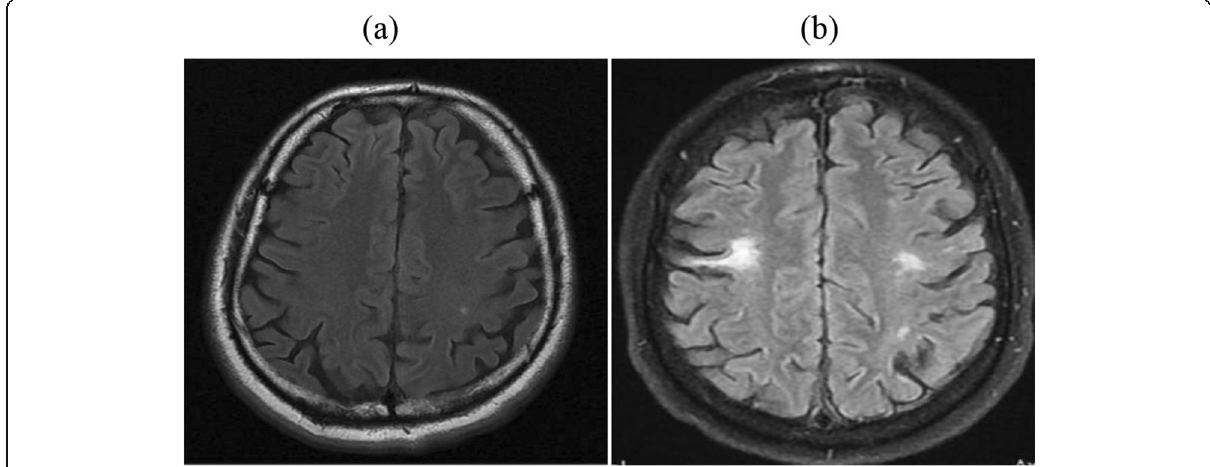
Fig. 1 a Axial FIAIR brain MRI exhibits non-specific hypertense white mater lesion in the left parietal region. b Axial FIAIR brain MRI exhibits hyperintensity lesions in both frontal subcortical white matter regions suggesting subacute infarcts. FIAIR, fluid-attenuated inversion recovery; MRI, magnetic resonance